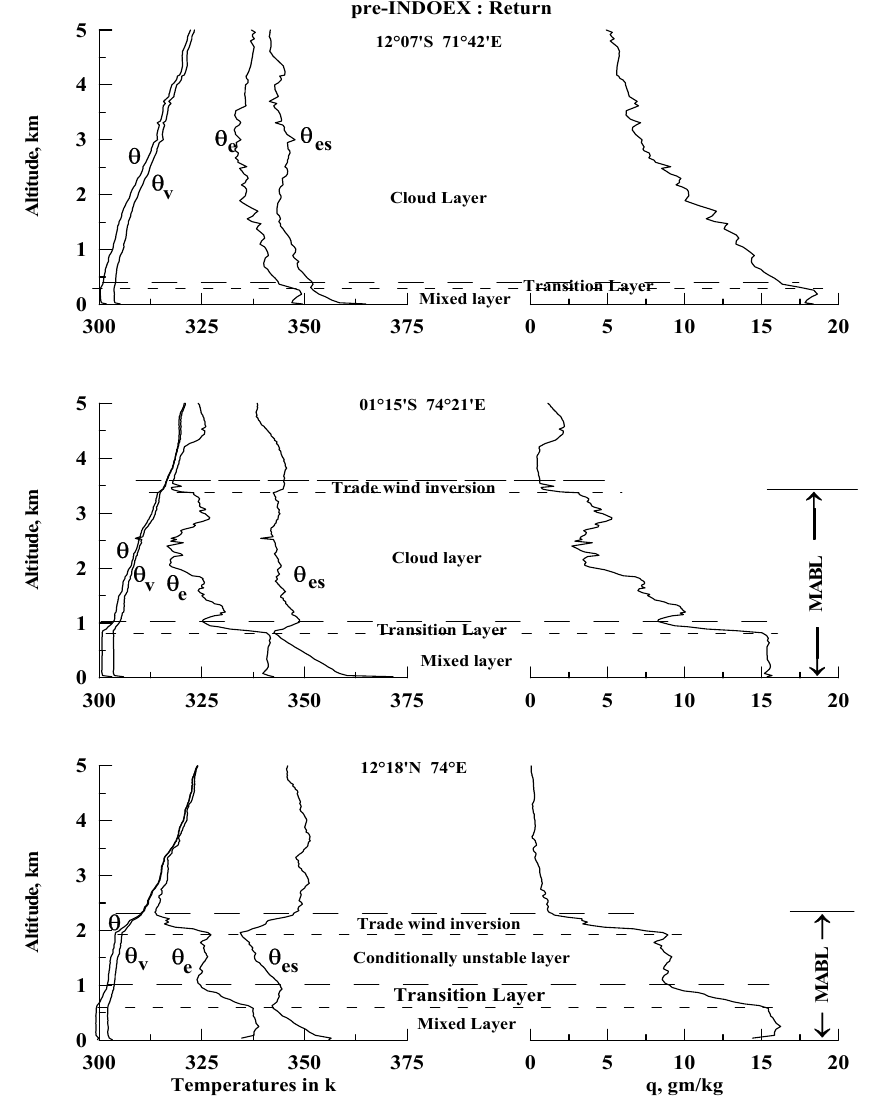
Figure 3 Fig. 3. Altitude profiles of potential temperature ( θ ), virtual potential temperature ( θ v ), equivalent potential temperature ( θ e ),